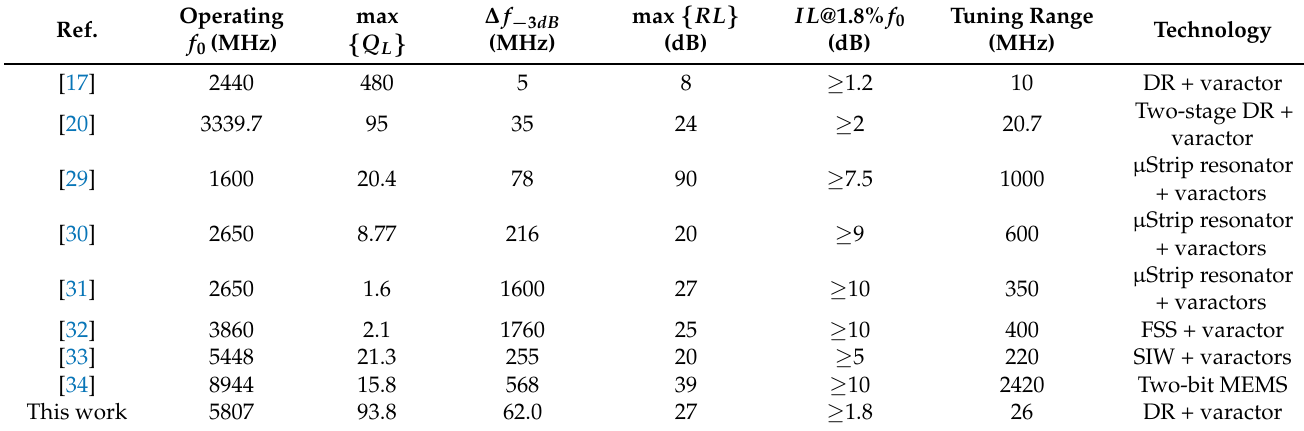
Table 4. Comparison with state-of-the-art tuneable band-stop filter technologies.